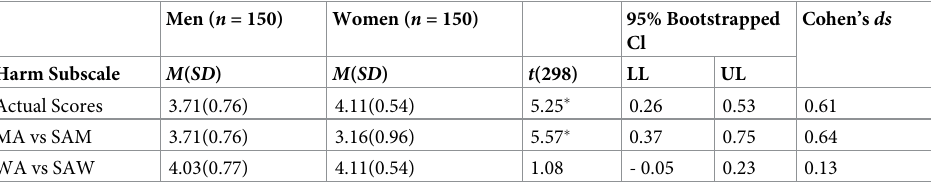
Table 2. Comparison of gender on actual and stereotype scores on harm subscale (N =